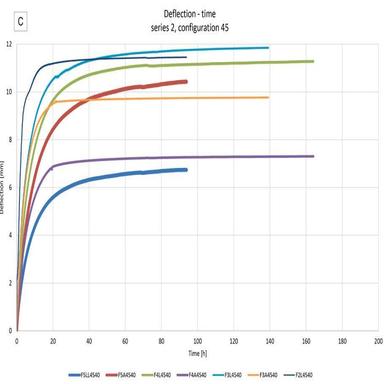
Maximum deflections over time of the second series, "configuration 45".